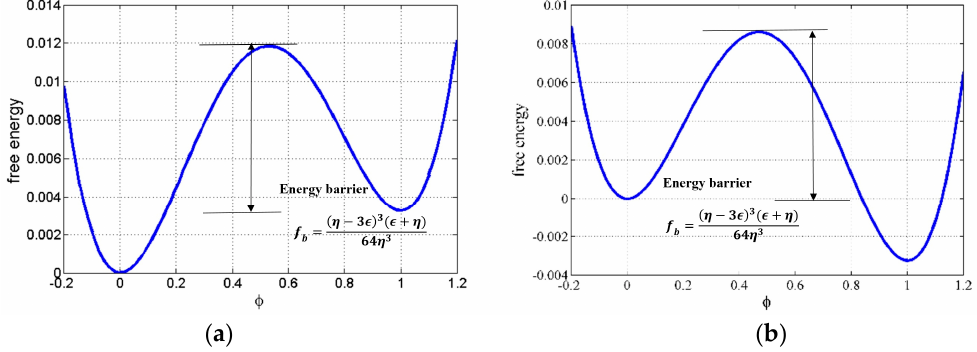
Figure 5. Uneven free energy: ( a ) η = 0.65 and ε = − 0.0130; and ( b ) η = 0.65 and ε =